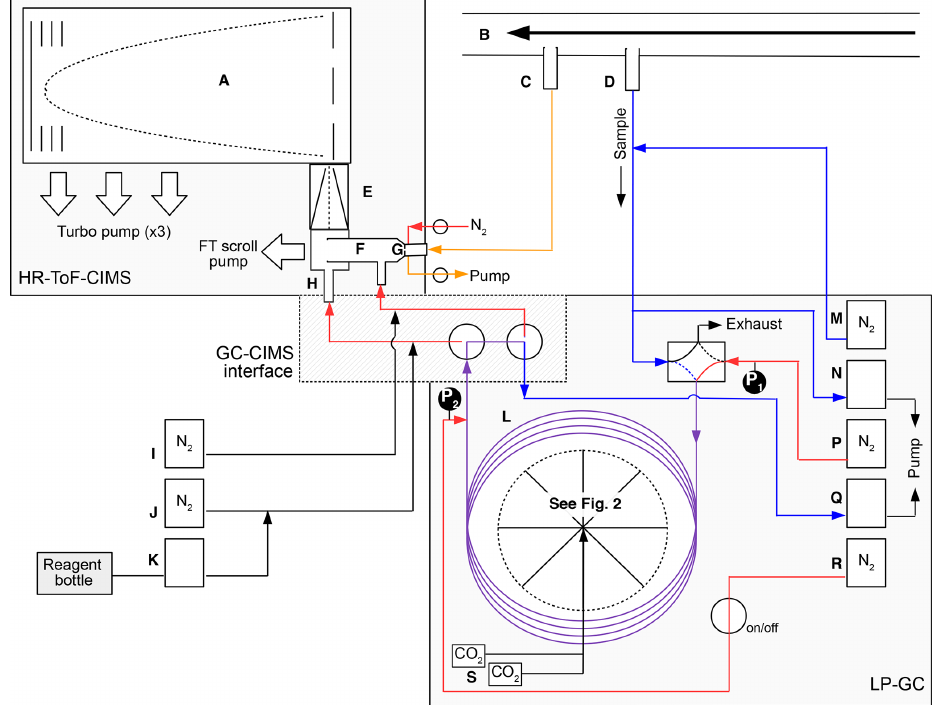
Figure 1. A simplified instrument schematic of GC-HRToF-CIMS showing the HRToF-CIMS, the LP-GC, and the interface between the two systems. The main components are (A) time-of-flight mass spectrometer, (B) Teflon-coated glass inlet, (C) CIMS sampling port, (D) GC– CIMS sampling port, (E) hexapole ion guide, (F) Teflon-coated glass flow tube, (G) critical orifice, (H) 210-Po ionization source, (I) CIMS dilution flow, (J) CIMS ion source dilution flow, (K) CF 3 OOCF 3 reagent flow, (L) GC column and cryotrap, (M) GC dilution flow, (N) GC sample intake pump, (P) GC column flow, (Q) GC bypass pump, (R) GC N 2 pickup flow, and (S) CO 2 solenoid valves. Pressure gauges at the head and tail of the column are denoted by P 1 and P 2 , respectively. Select instrument flow states are differentiated by the various line colors, for which orange represents the flow path during direct CIMS sampling, blue represents the path GC trapping, and red represents the path during GC elution. Analytical lines that are used during both GC trapping and eluting are purple. Diagram is not to